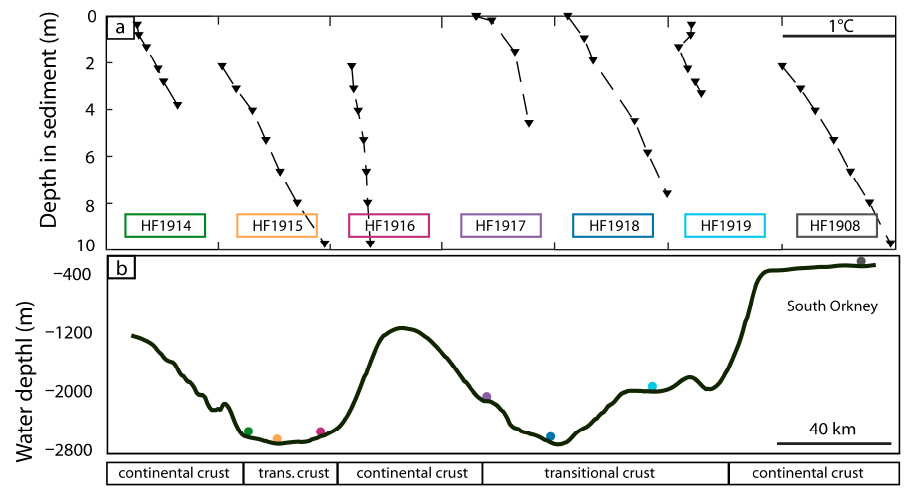
Figure 7. ( a ) Northern temperature-depth Profile 1 across the Powell Basin. ( b ) Location of the sea floor with reference to sea level and stations of the individual in situ temperature measurements indicated by colored circles. Crustal segments after [37].